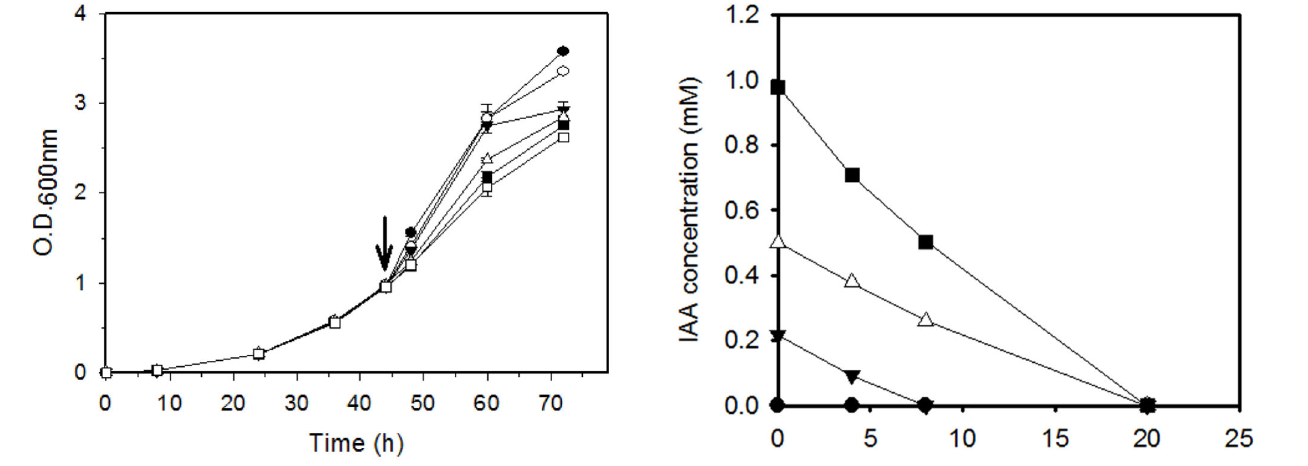
Figure 1. The growth characteristics of B. japonicum in response to IAA treatments. An arrow indicates the time (t = 44 h; O.D. ~ 1.0) at which IAA was added to cultures. The 600 symbol legend is as follows: (-●-), control (no IAA); (-○-), 0.25 mM; (--), 0.5 mM; (-Δ-), 1 mM; (-■-), 2 mM; and (-□-), 5 mM. Each point is the mean ± standard error of the mean for three biological replicates.